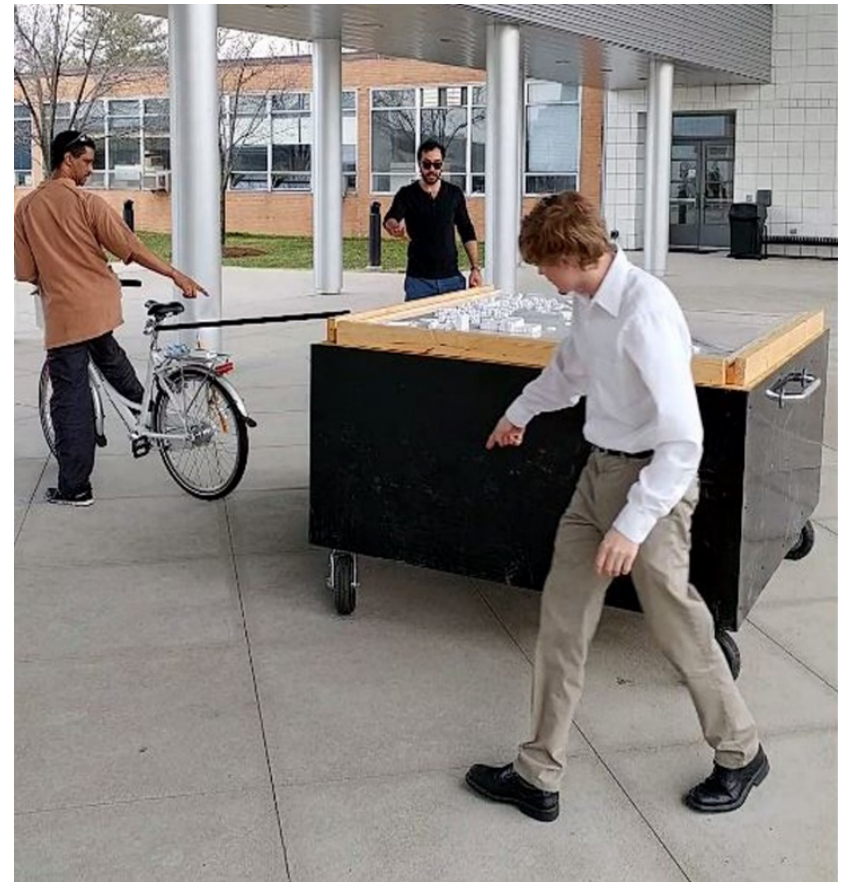
Figure 6. Testing a completed MMS and pulling it by bicycle.